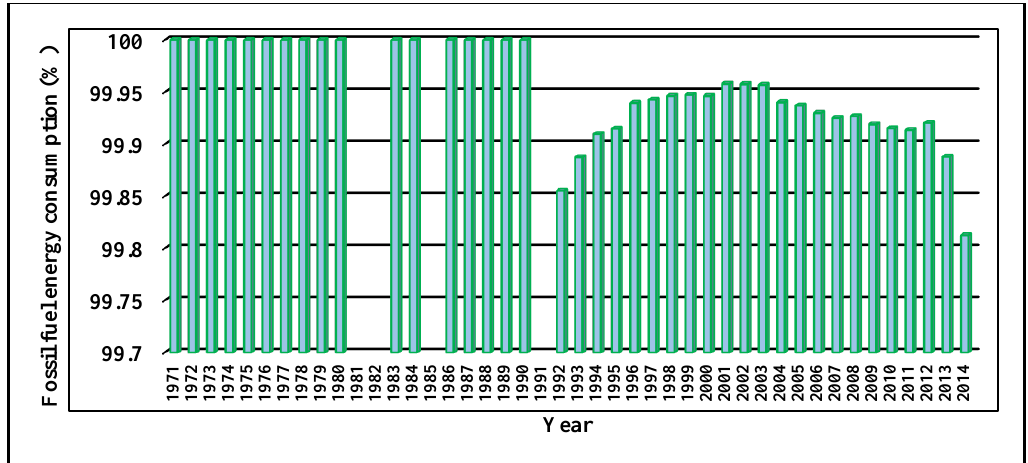
Figure 9. Fossil fuel energy consumption in the UAE [63].